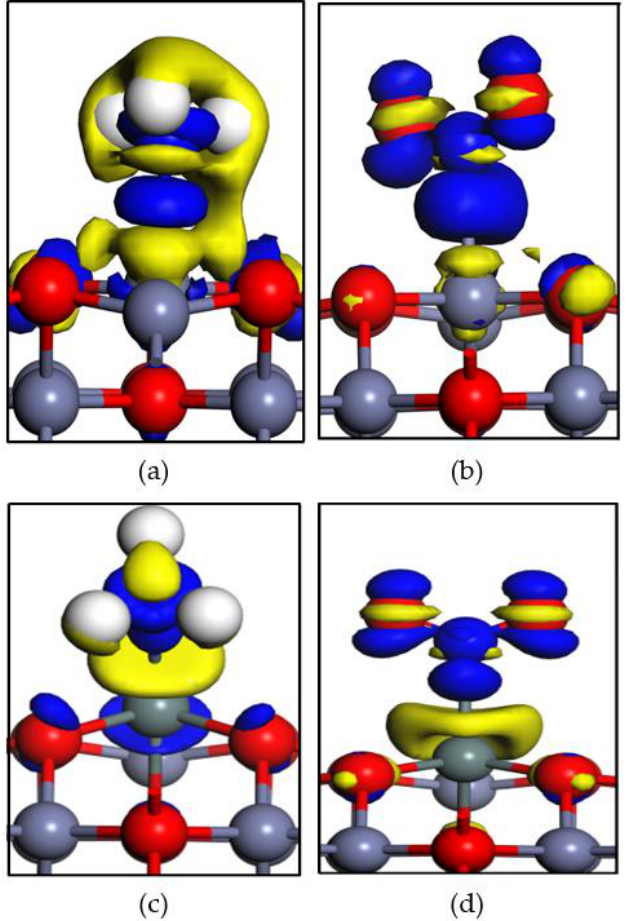
Figure 8. Charge density difference for ( a ) NH 3 /ZnO (101) surface, ( b ) NO 2 /ZnO (101), ( c ) NH 3 /Sn − doped ZnO (101), and ( d ) NO 2 /Sn − doped ZnO (101) surface. The blue and yellow regions show electron accumulation and depletion, respectively.